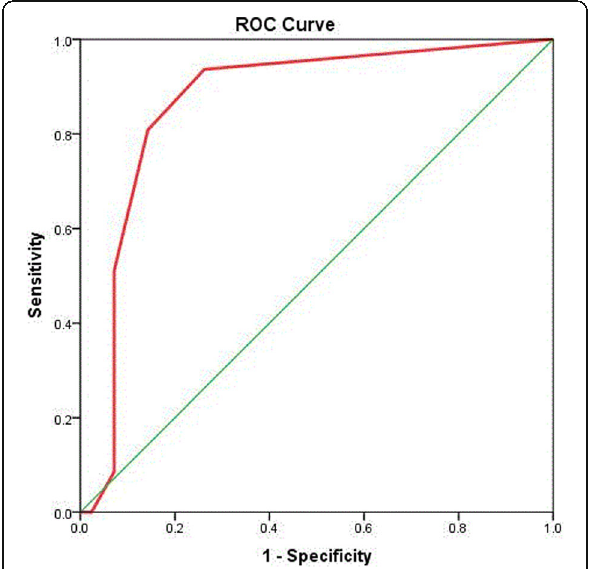
Fig. 2 ROC curve analysis of WBCs between stable and exacerbation